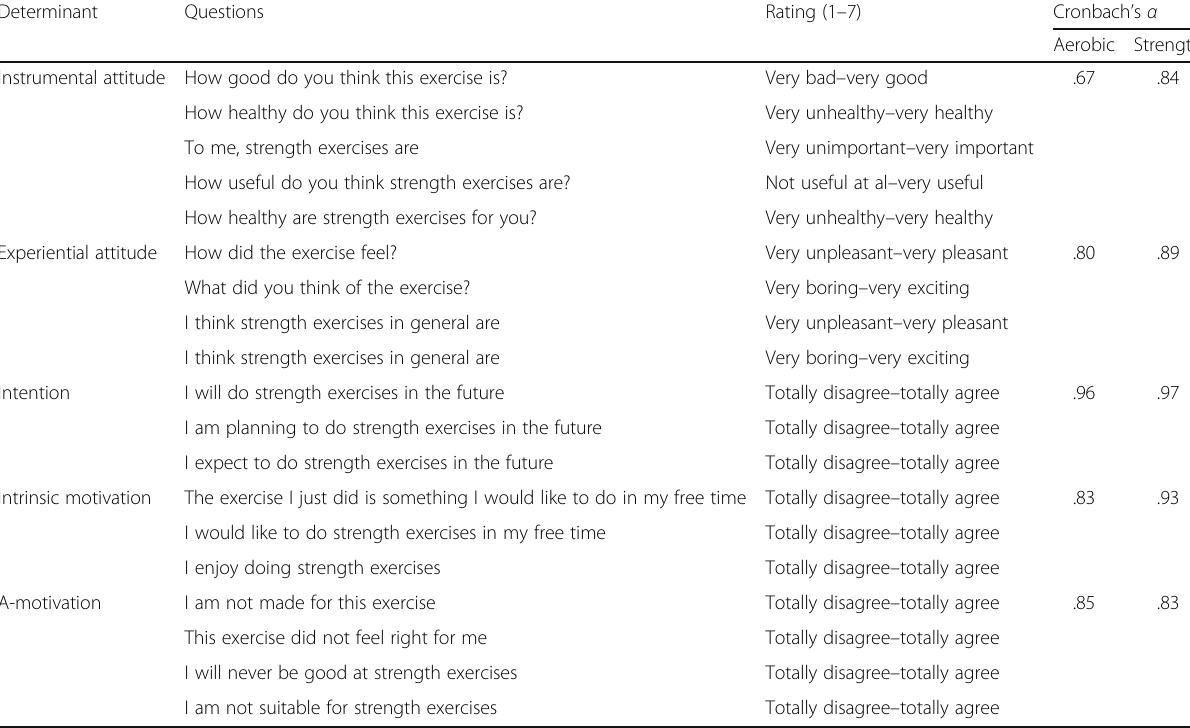
Table 1 Attitudes, intentions, and motivations related to aerobic and resistance exercises ( n = 68)